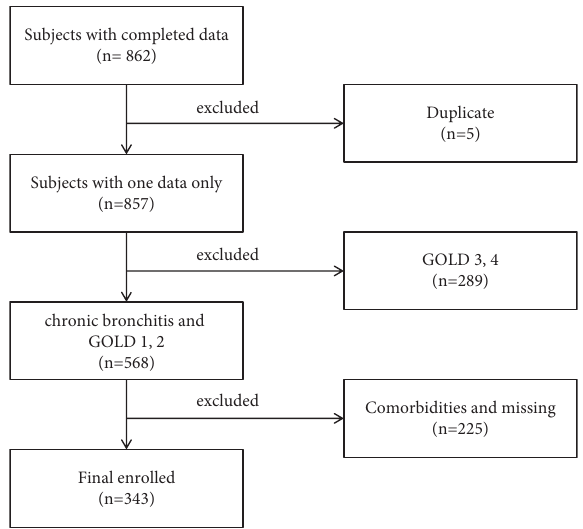
Figure 1: Patient selection. Totally, 862 patients were enrolled. 5 patients who rehospitalization during 2014–2017; 289 patients who defined as GOLD grades 3 and 4; and 225 patients who exhibited comorbidities and/or data missing were excluded. Complete data were available for 157 CB and 186 COPD